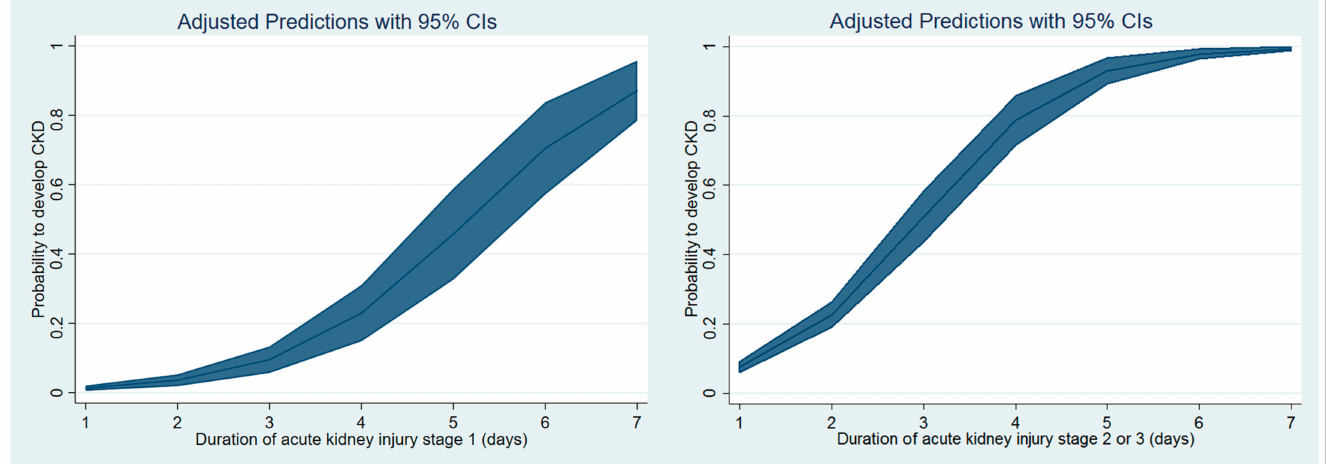
Figure 2. Cubic spline function curves of the relationship between the duration of acute kidney injury and the probability of developing chronic kidney disease as determined by estimated glomerular filtration rate of less than 60 mL/h/1.73 m 2 . CKD = chronic kidney